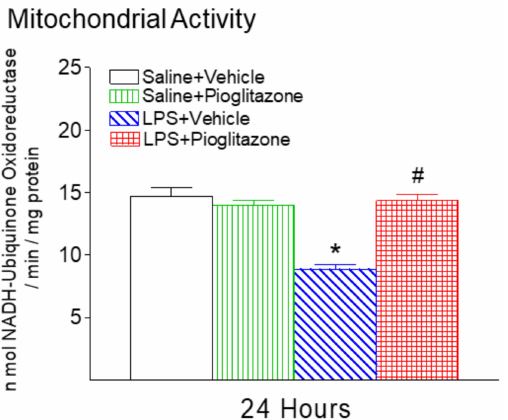
Figure 6. Pioglitazone attenuated neonatal LPS-induced reduction of mitochondrial complex I enzymatic activity in the rat brain. The results are expressed as the mean ± SEM of eight animals in each group, and analyzed by two-way ANOVA, followed by the Student–Newman–Keuls test. * p < 0.05 represents a significant difference for the LPS + Vehicle group as compared with the Saline + Vehicle group. # p < 0.05 represents a significant difference for the LPS + Pioglitazone group as compared with the LPS + Vehicle group.